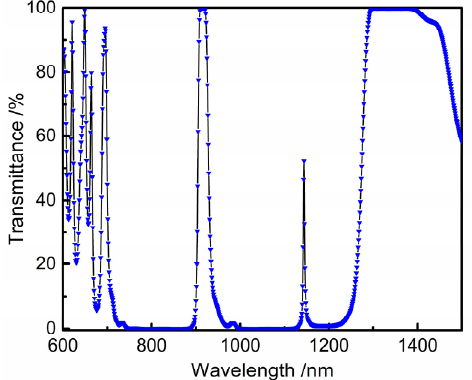
Figure 5. Theoretically calculated transmittance spectral curve of multilayer optical coatings for the output surface.